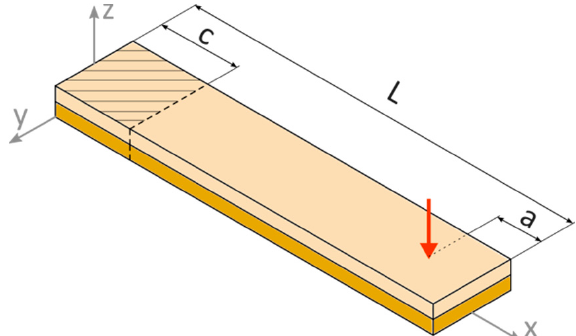
Figure 7. Configuration of the particulate composite beam in FEM simulations: L—length of beam, a—distance between the moving end of the beam and application point of the external kinematic load, c—clamped part of the beam.